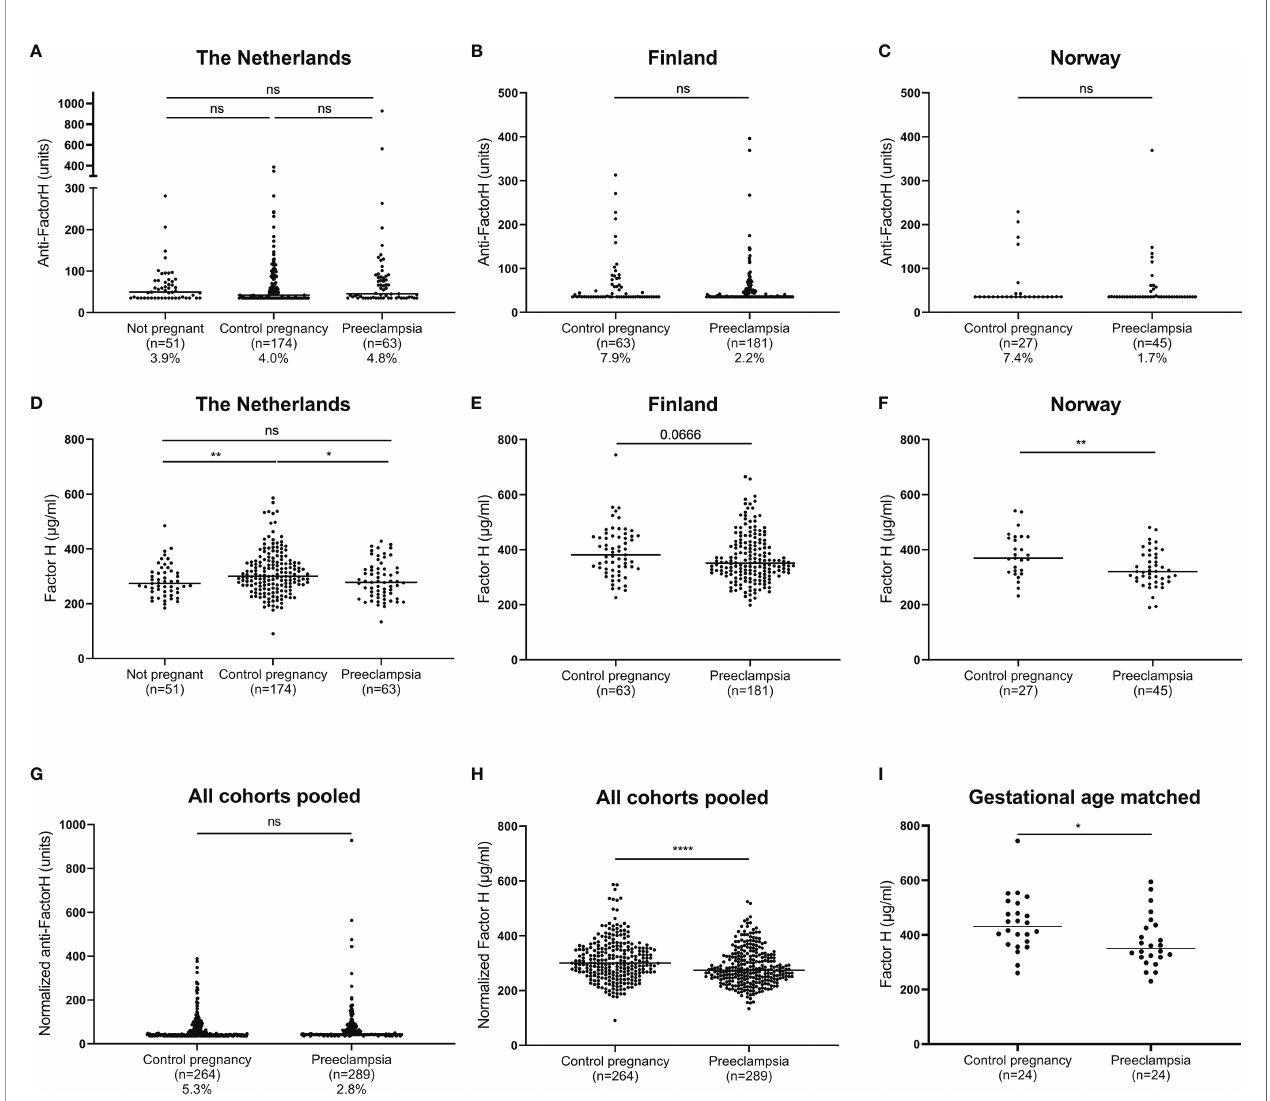
FIGURE 2 | Anti-Factor H antibodies and Factor H in healthy or PE pregnancy. Anti-Factor H antibodies measured in maternal serum in cohorts from the Netherlands (A) , Finland (B) and Norway (C) , dotted line indicates the detection limit at 35.2 units. Factor H concentration measured in maternal serum in cohorts from the Netherlands (D) , Finland (E) and Norway (F) . Data from different cohorts was normalized and pooled for anti-FH (G) and FH (H) . For the cohort from Finland, a subanalysis with samples matched for gestational age was additionally performed (I) . Comparisons tested by Mann-Whitney, or paired t test for panel I; ns, not signi fi cant (p > 0.05); *, 0.05 < p < 0.01; **, 0.001 < p < 0.01; ****, p <